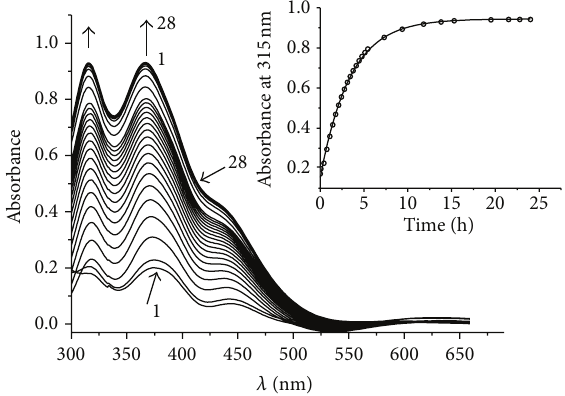
Figure 7: Kinetics of change of absorption spectrum of ( I ) ( 1.5 ⋅ 10 −4 M): spectra were registered at 30 s (1) , 9min (2) after start of reaction. Spectra 3–12 were registered further with interval of 20 min. Spectra 13–22 were registered at 4.1 (13), 5.2 (14), 6.3 (15), 8.2 (16), 10 (17), 14.9 (18), 17.1 (19), 20.1 (20), 22 (21), and 24 (22) h after start of reaction. Conditions of reaction: 25 ∘ C solvent is 0.05 M Tris-HCl buffer, pH 7.0. Spectra 1–22 have 2 maxima: 𝜆 1 = 311 hm K 𝜆 2 = 353 hm. The inset shows kinetics of the decomposition of ( I ) ( 1.5 ⋅ 10 −4 M) in 0.05 M Tris-HCl-buffer pH 7.0 at 25 ∘ C (for the experimental data shown on this figure). Circles are the experimental data.